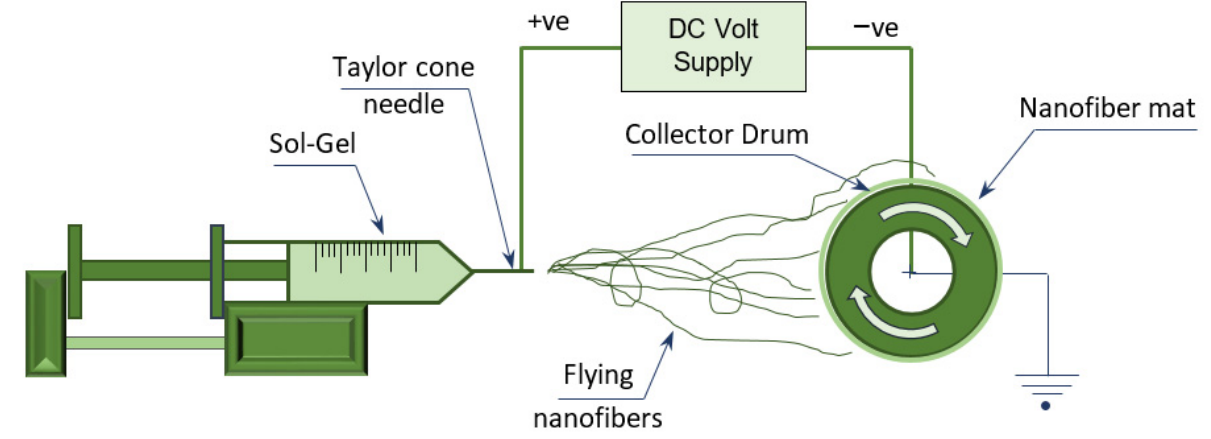
Figure 1. Schematic layout for the electrospinning device